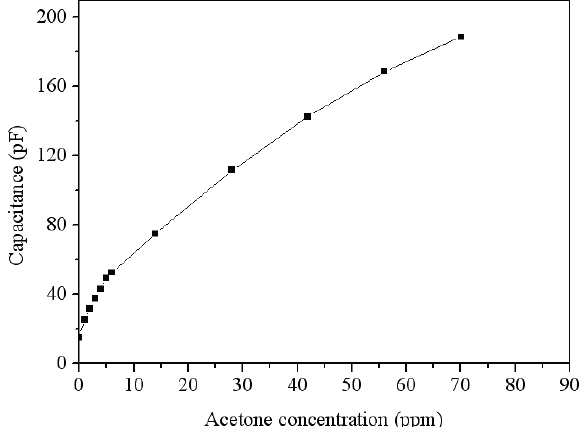
Figure 14. Relation between capacitance and acetone concentration for the acetone